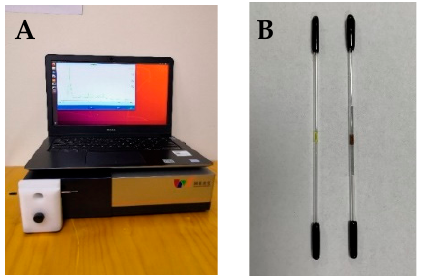
Figure 1. MOI instrument and sample configuration for ( A ) portable desktop Raman unit and ( B ) gold SERS capillary sensors before reduction on the left and after reduction on the right. Note that the rubber tips are attached after the sol–gel is drawn into the capillary, and they remain attached during the curing stage and in storage (on left ) and are then removed prior to the reduction step. The reusable rubber tips are then reattached after the reducing agent is flowed through sol–gel plug and subsequent water washing step, and they remain attached until it is time to add the sample (on right ).